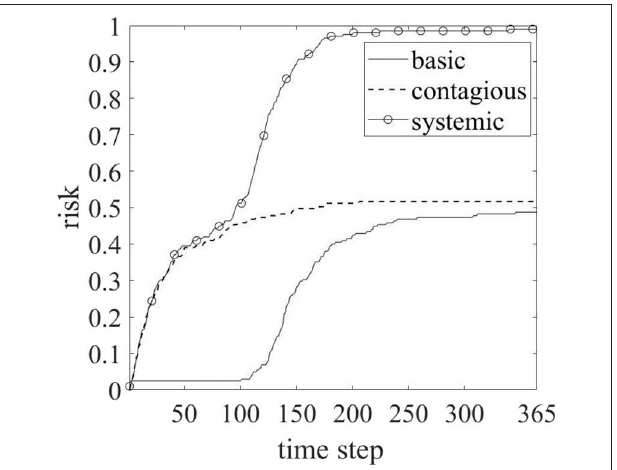
FIGURE 7 | Dynamic evolution curve of basic default, contagious, and systemic risk of Chinese banking system.